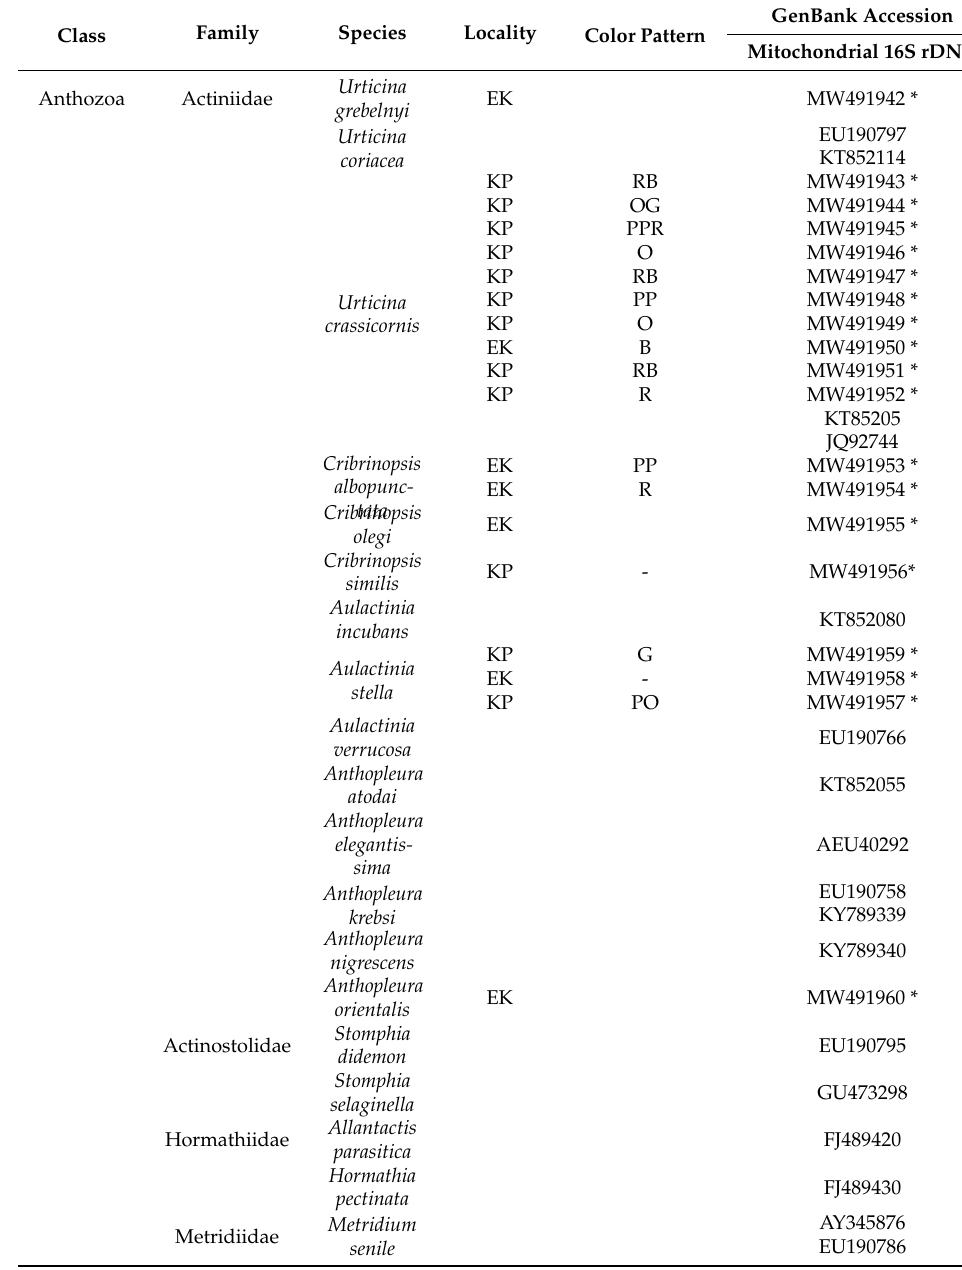
Table 1. Species analyzed phylogenetically based on partial sequences of the mitochondrial 16S rDNA gene. The collection site of species reported in this study (KP—Kola Peninsula, EK—East Kamchatka) and color patterns for specimens of species variable in their coloration: Urticina crassicor- nis , Cribrinopsis similis , C. albopunctata , and Aulactinia stella , are as follows: (PPR—pale pink with red stripes, PP—pale pink, RB—red–blue blotched, PO—pale orange, OG—orange with gray tentacles, O—orange, R—red, G—gray, B—beige). * sequences reported in this study (Clustal X), - no